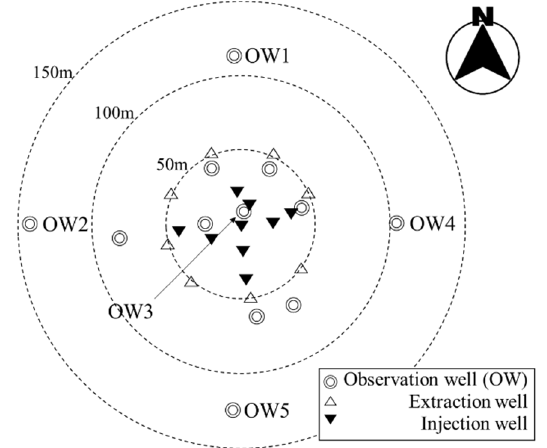
Figure 3. Arrangement of the wells used for the ASTR technique.